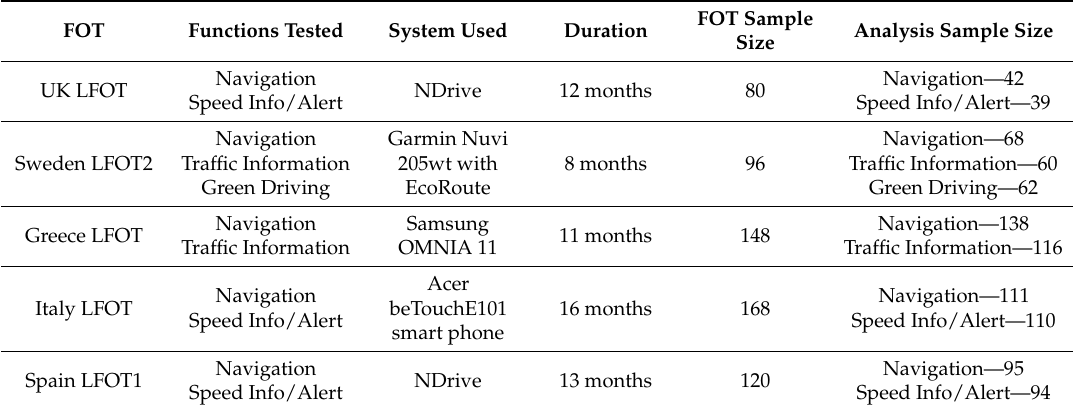
Table 1. TeleFOT field operational tests included in the “safety” perception